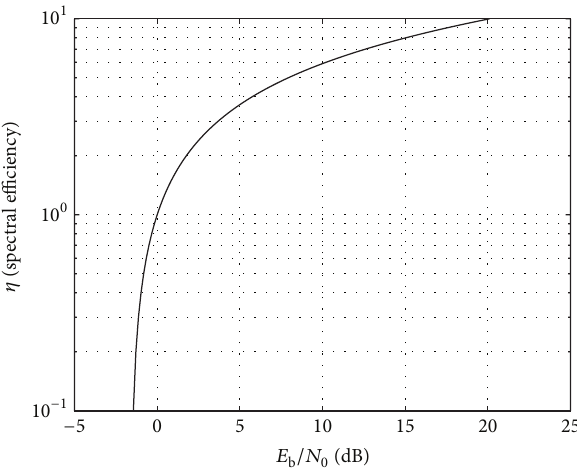
Figure 1: Capacity curve: limit of (𝐸 b /𝑁 0 ) dB Req , Coded